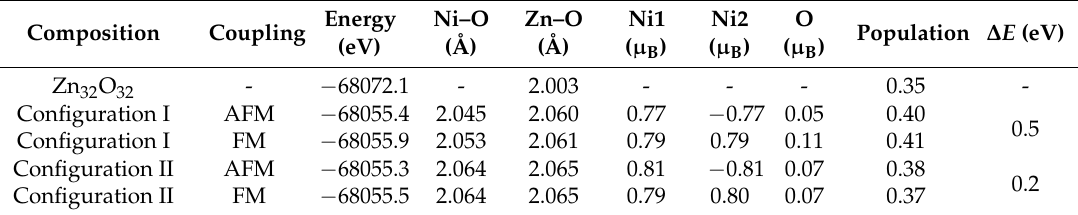
Table 2. Energy, magnetic coupling, bond length, and magnetic moments of Ni-doped ZB